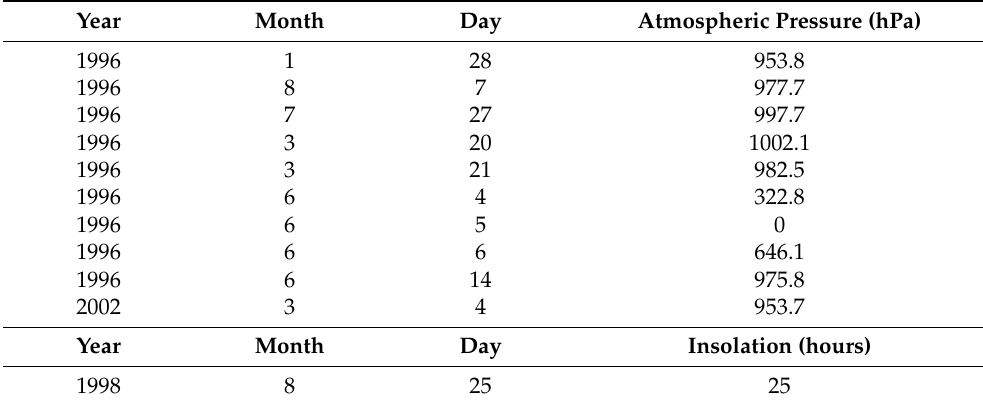
Table 2. Doubtful values found by the QCS through the fixed limit test for atmospheric pressure (in hPa) and insolation (in hours/day).